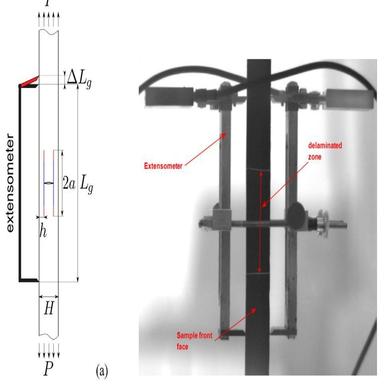
(a) Sketch of an MTCT sample instrumented with the extensometer; (b) image of the HBM-dd1 strain indicator assembled in an averaging double opposed clamp-on configuration.